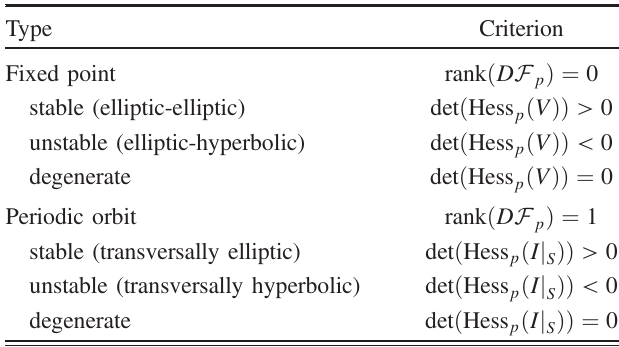
TABLE I. Classification of a critical point p by rank and stability. The terminology in parentheses is taken from